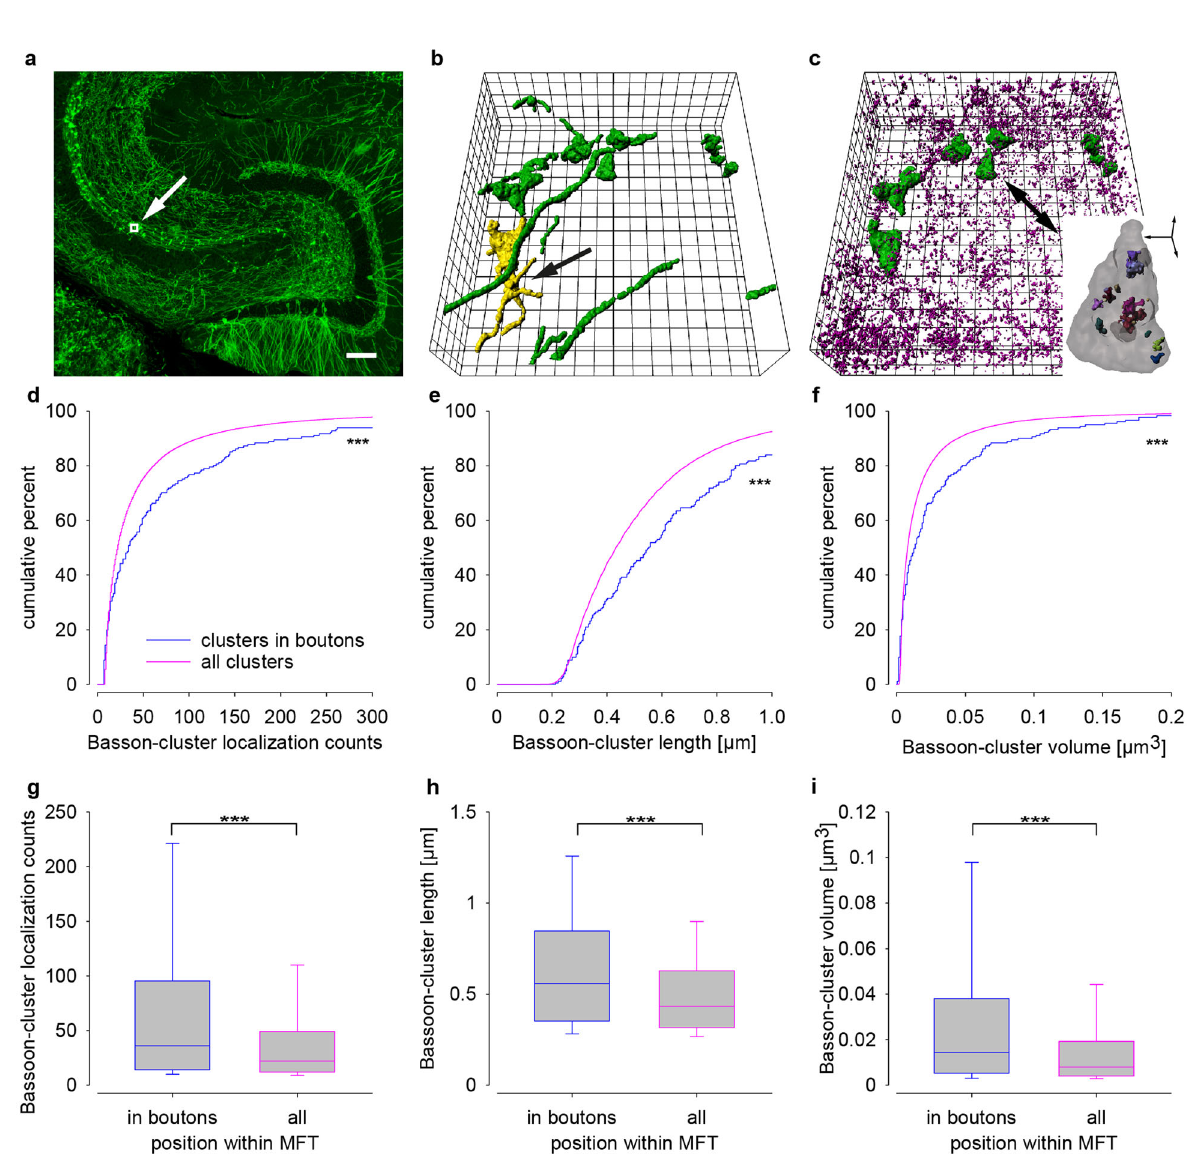
Fig. 7 Sequential en bloc 3D imaging in 25 µ m thick tissue slices of mEGFP(Ls1) mice showed largest Bassoon clusters in identi fi ed mossy fi ber boutons. a Confocal overview of mossy fi bers in a Thy-1 mEGFP(Ls1) mouse with imaging window (25 × 25 µ m) depicted to scale. b 3D volume reconstruction of mEGFP in xyz -view, showing axons and mossy fi ber boutons (green), a typical bouton with fi lopodial extensions is marked in yellow (black arrow). c 3D reconstruction of Bassoon (magenta) and mEGFP (green) in large mossy fi ber boutons used for calculations of “ clusters in boutons ” in d – i ; inset depicts the marked bouton (black arrow) with Bassoon clusters (colored). Cumulative plots of localization counts ( d ), cluster length ( e ), and volumes ( f ) comparing all clusters per image (magenta) and those in identi fi ed boutons (blue). Corresponding data as box plots g – i . Scale bar: 100 µ m ( a ), grid size 2 µ m ( b , c ) and scale bar for inset in c 1 µ m. Asterisks (*** p < 0.001) denote statistical signi fi cance between the groups.